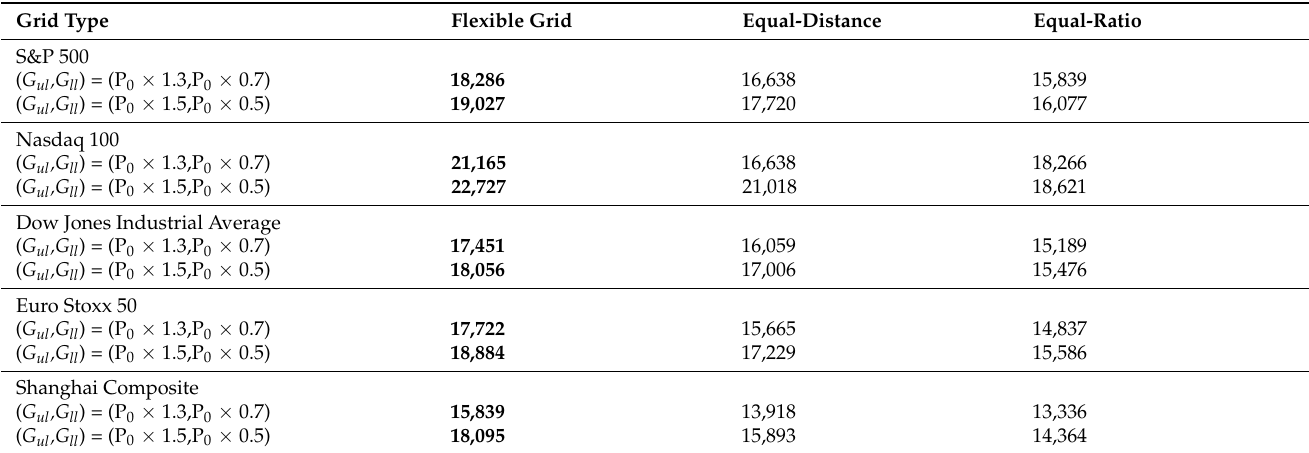
Table 10. Accumulated wealth obtained by flexible grid, equal-distance grid, and equal-ratio grid with SSO parameters.